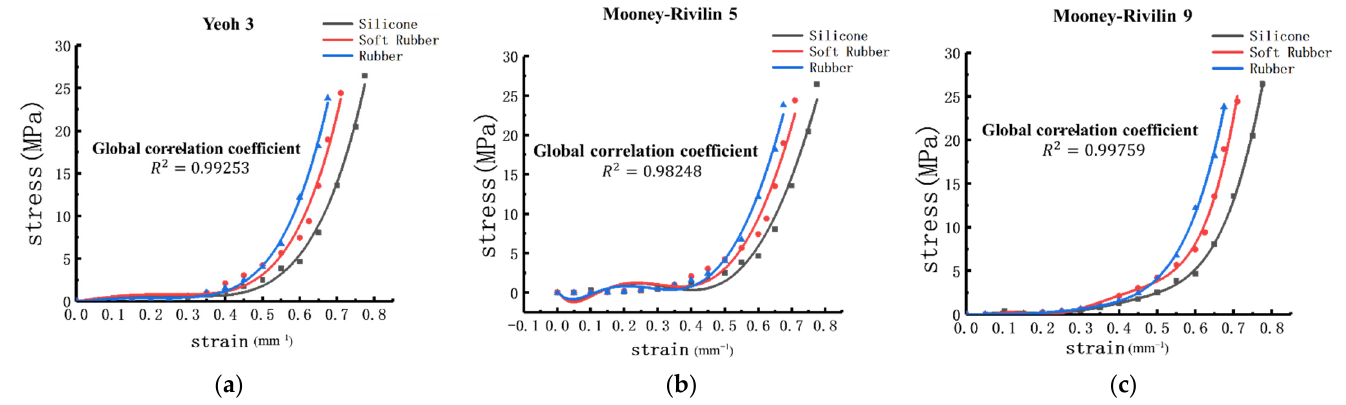
Figure 4. Fitting diagram of independent correlation coefficient.